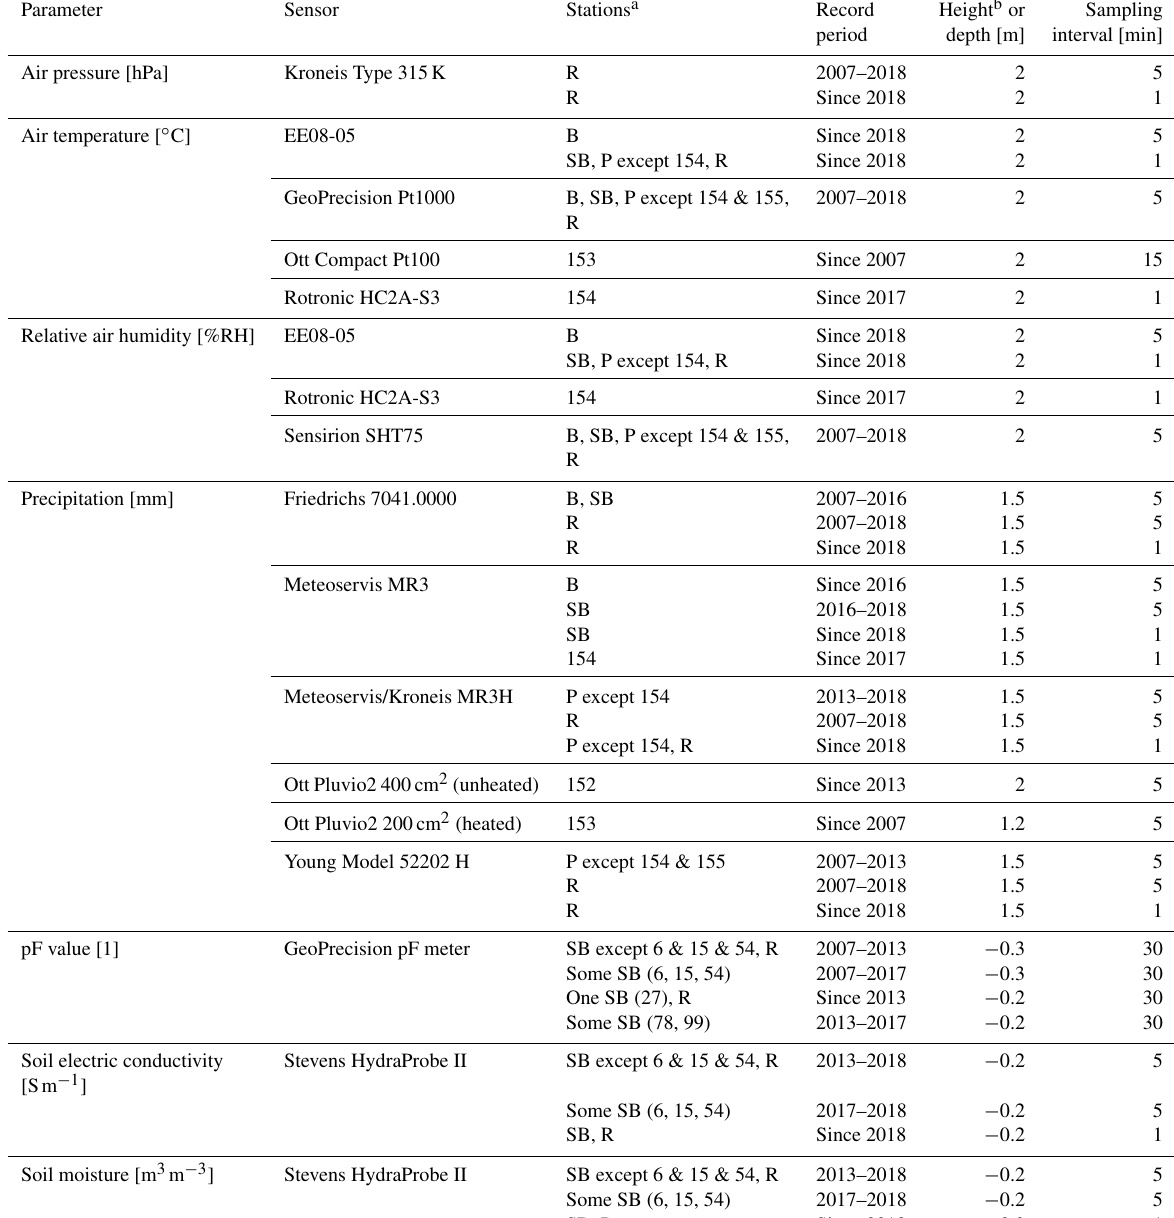
Table A1. Sensors installed in the WegenerNet FBR (alphabetical order by parameter); installed data loggers are stated in the table’s bottom